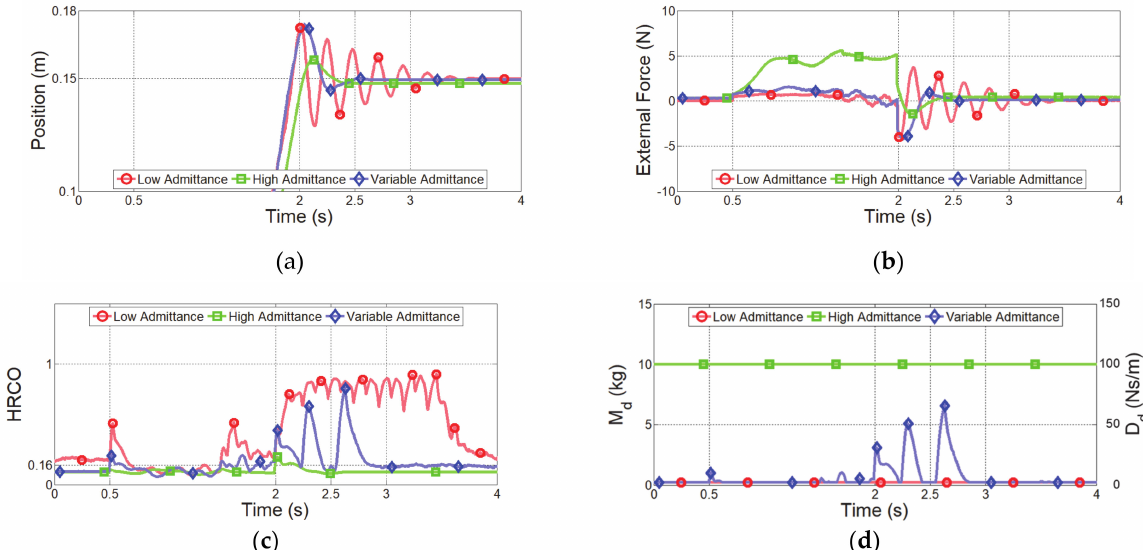
Figure 9. Experimental results of controllers under sudden change in operator’s intention. ( a ) End-effector position along x axis, ( b ) external force along x axis, ( c ) HRCO output, and ( d ) admittance parameters.